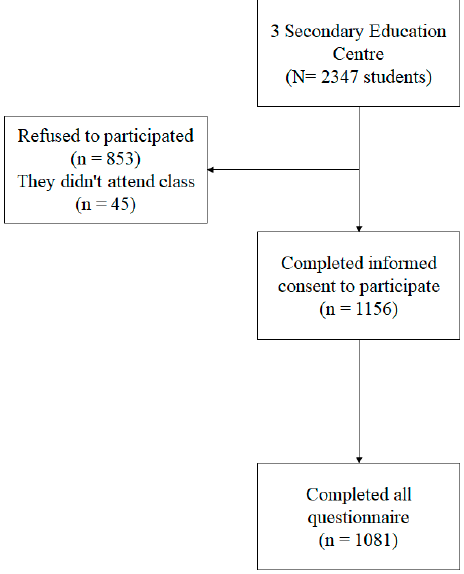
Figure 1. Sample flowchart.